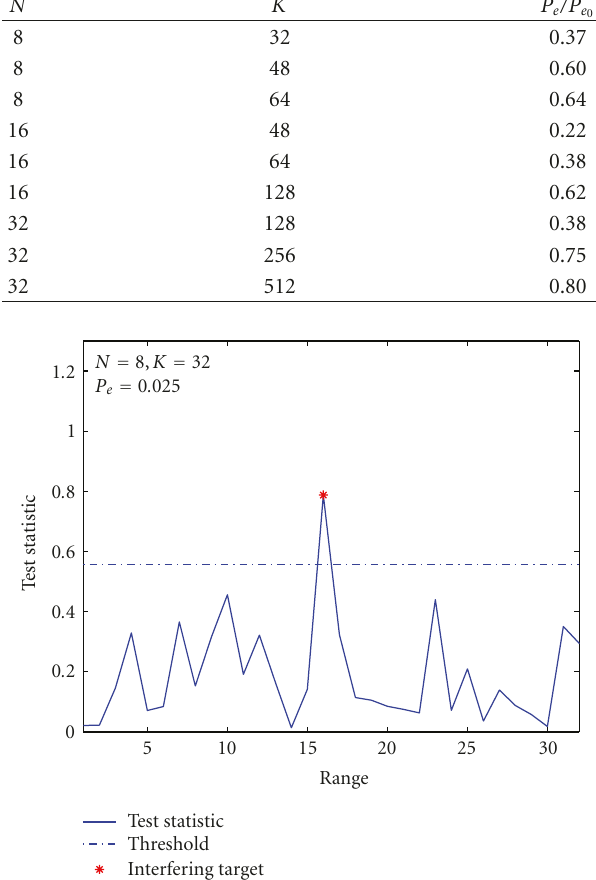
Figure 6: Test statistic versus range in nonhomogeneous K - distributed clutter with n i = 1 interfering target using N it = 1